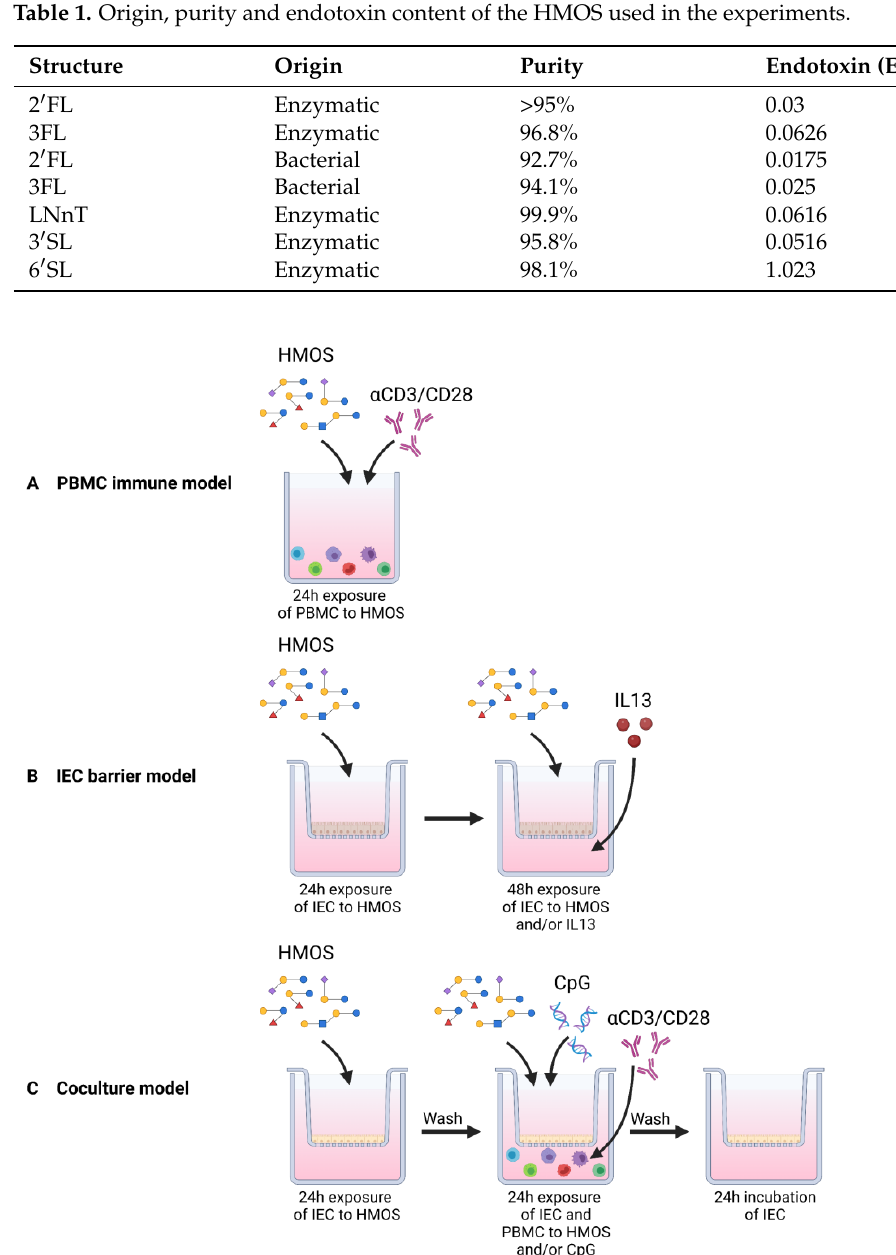
Figure 1. Schematic overview of the different models described in this manuscript. ( A ) The PBMC immune model allowed for direct exposure of activated PBMCs to HMOS. Freshly isolated PBMC were activated using anti-CD3 and anti-CD28, while being exposed to HMOS for 24 h. ( B ) In the IEC barrier model, T84 cells were cultured in transwell inserts for 4 weeks. Cells were apically pre-exposed to HMOS for 24 h prior to basolateral addition of IL13 to induce barrier disruption. ( C ) For the IEC/PBMC coculture model, human intestinal IEC (HT29 cells) were cultured on transwell inserts until confluency was reached. IEC were apically exposed to HMOS for 24 h. After preincubation with HMOS, the apical an basolateral medium was refreshed. αCD3/CD28-activated PBMCs were added to basolateral compartment. IEC were apically exposed to HMOS again either in presence or absence of CpG. After 24 h of coculture, basolateral supernatant was collected to measure cytokine secretion and PBMCs were collected for phenotypical analysis. IEC were again washed and incubated for another 24 h in fresh medium to measure epithelial mediator release into the basolateral compartment.